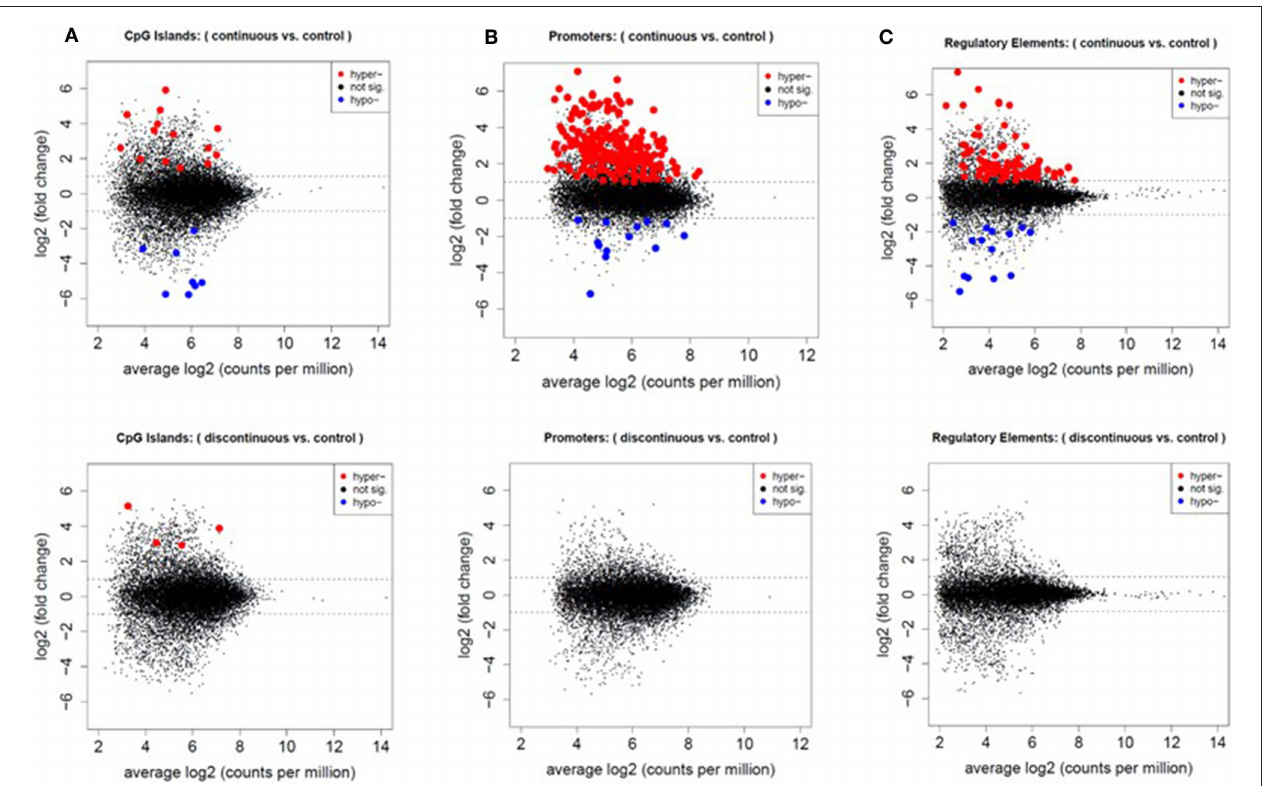
FIGURE 3 | Increased number of differentially methylated regions in the continuous exposure group. CpG sites were grouped by CpG islands (A) , promoter regions (B) , and regulatory elements (C) as described in the methods. Differentially methylated regions were analyzed using edgeR glmLRT. Graphs of the MD-plots represent the fold change (log2) between either continuous vs. control or discontinuous vs. control. DMRs were considered significant with an FDR-adjusted p ≤ 0.05 and fold change >